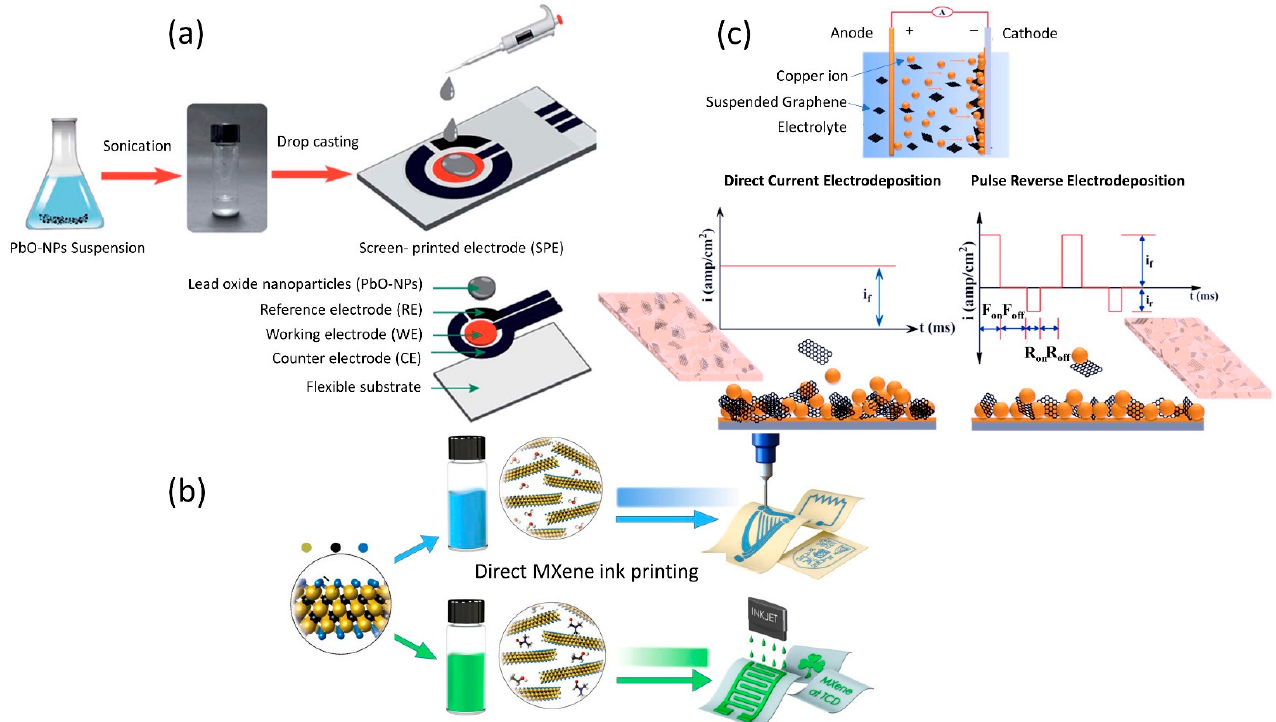
Figure 3. Surface modification or functionalization techniques of printed electrochemical sensors with nanomaterials. ( a ) Drop-casting technique. Reproduced/Adapted from Ref. [89] with permission from The Royal Society of Chemistry. ( b ) Ink-mixing and printing technique. Reprinted with Attribution (CC BY) license. ( c ) Electrodeposition technique. Reprinted with permission from